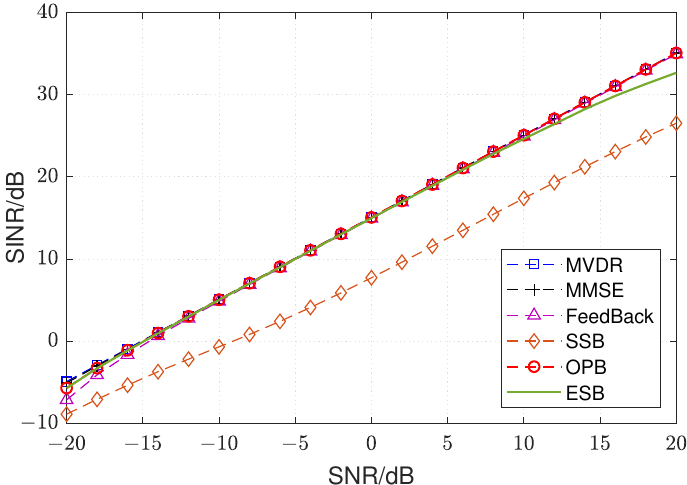
Figure 7. Output SINR versus the input